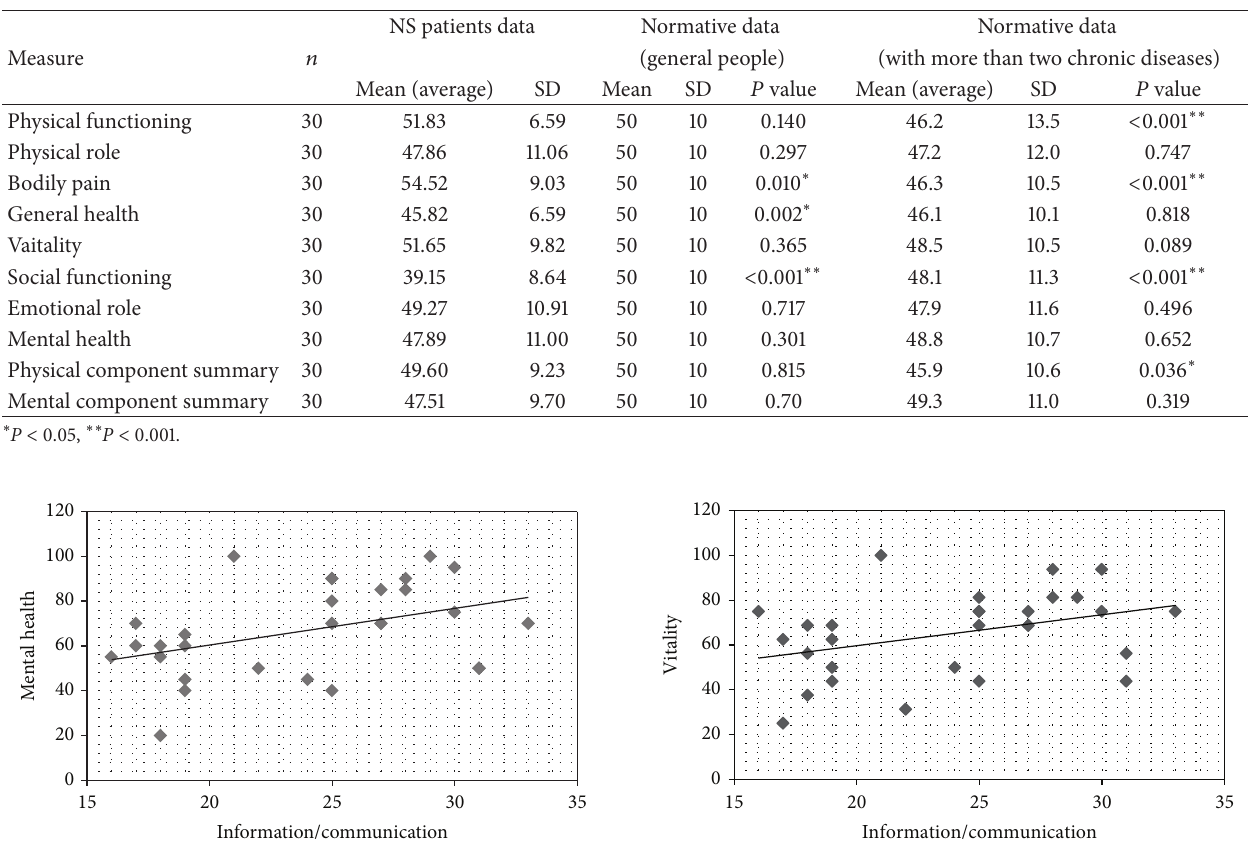
Table 2: QOL scores compared with Japanese normative data (2007).